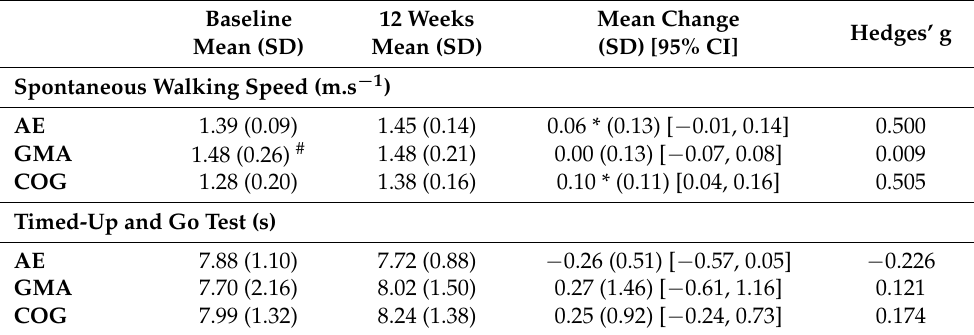
Table 2. Mobility performances per intervention